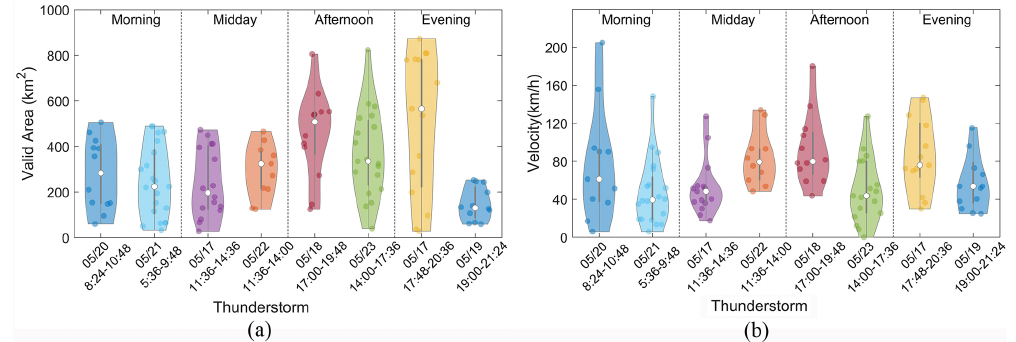
Figure 7. (a) Comparison of the valid area between eight cases. The upper and lower edges of boxes mean the maximum and minimum values. The white circle in each box represents the median of VA. The filled circles with a darker colour than the box represent all VA values of thunderstorms. The grey vertical line in the box represents the interquartile range of VA. (b) Same as (a) but for the